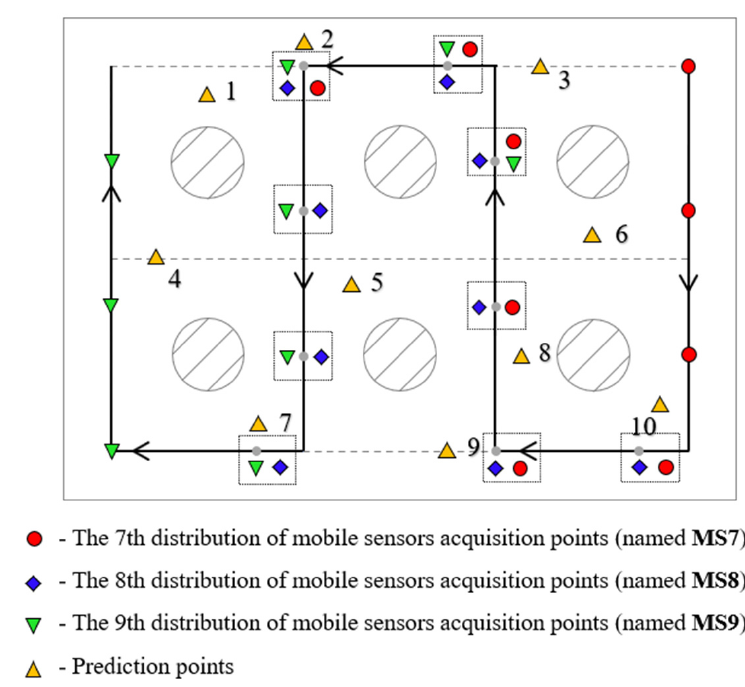
Figure 12. Prediction of mobile sensors with acquisition distance of 2.0 m.